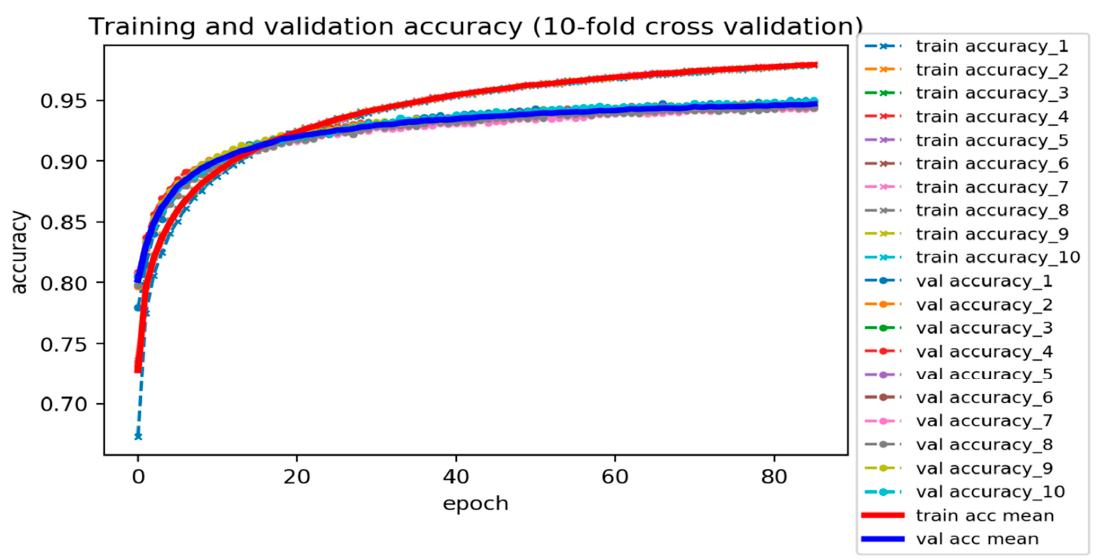
Figure 6. Training and validation accuracy of DNN-based DTI model (10-fold cross validation). Table 4. 10-fold cross-validation measure for the DNN-based DTI model. Model Performance (10-Fold Cross-Validation)